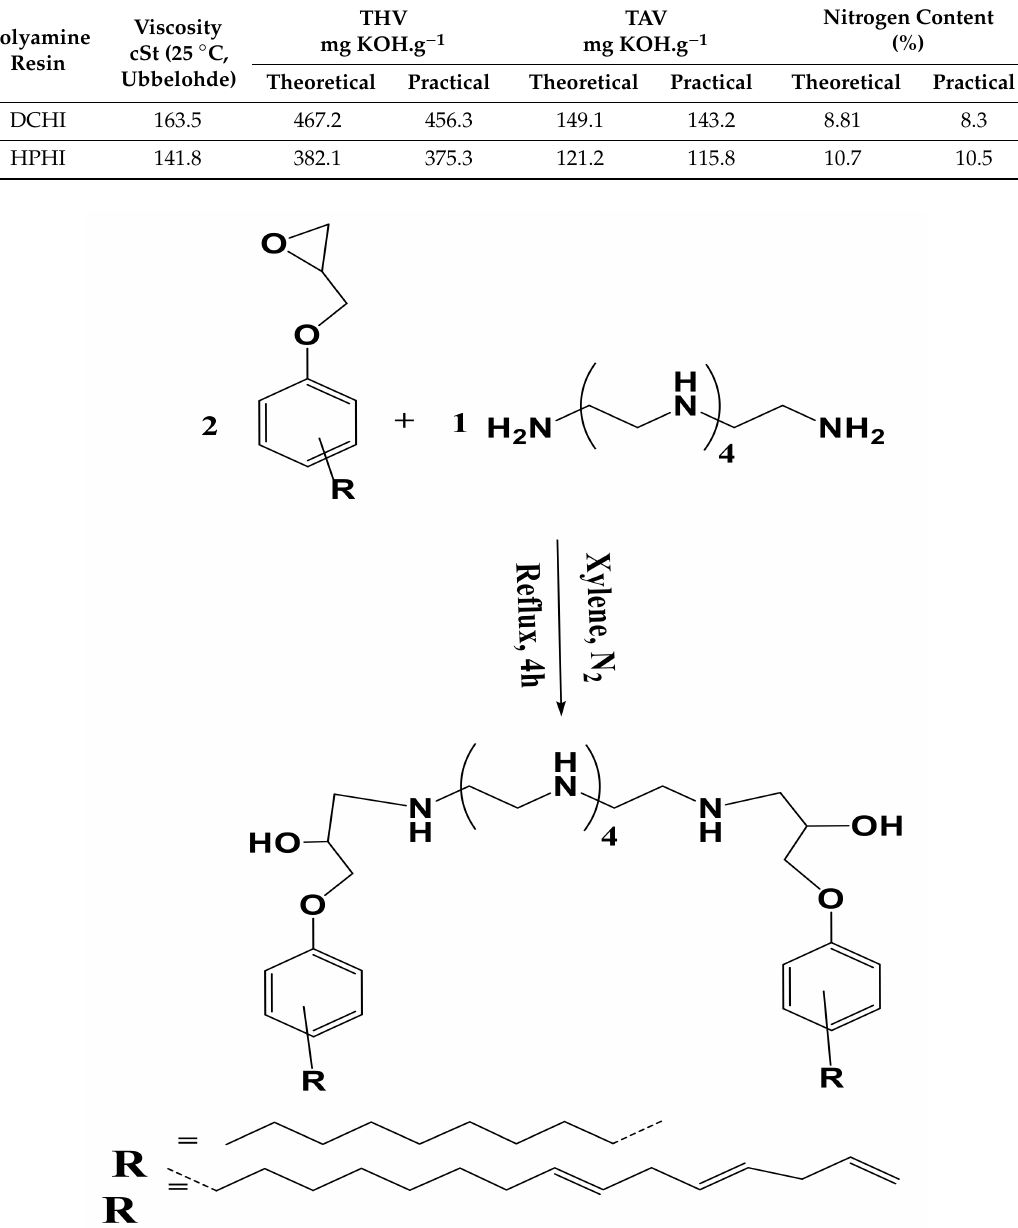
Table 1. Physico-chemical analysis of polyamine resins. DCHI, dicardanoxy; HPHI, dinonylphenoxy; THV, total hydroxyl value; TAV, total amine